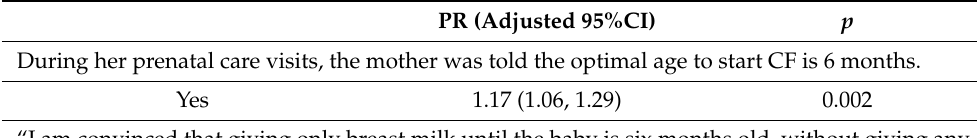
Table 3. Factors related to starting timely complementary feeding